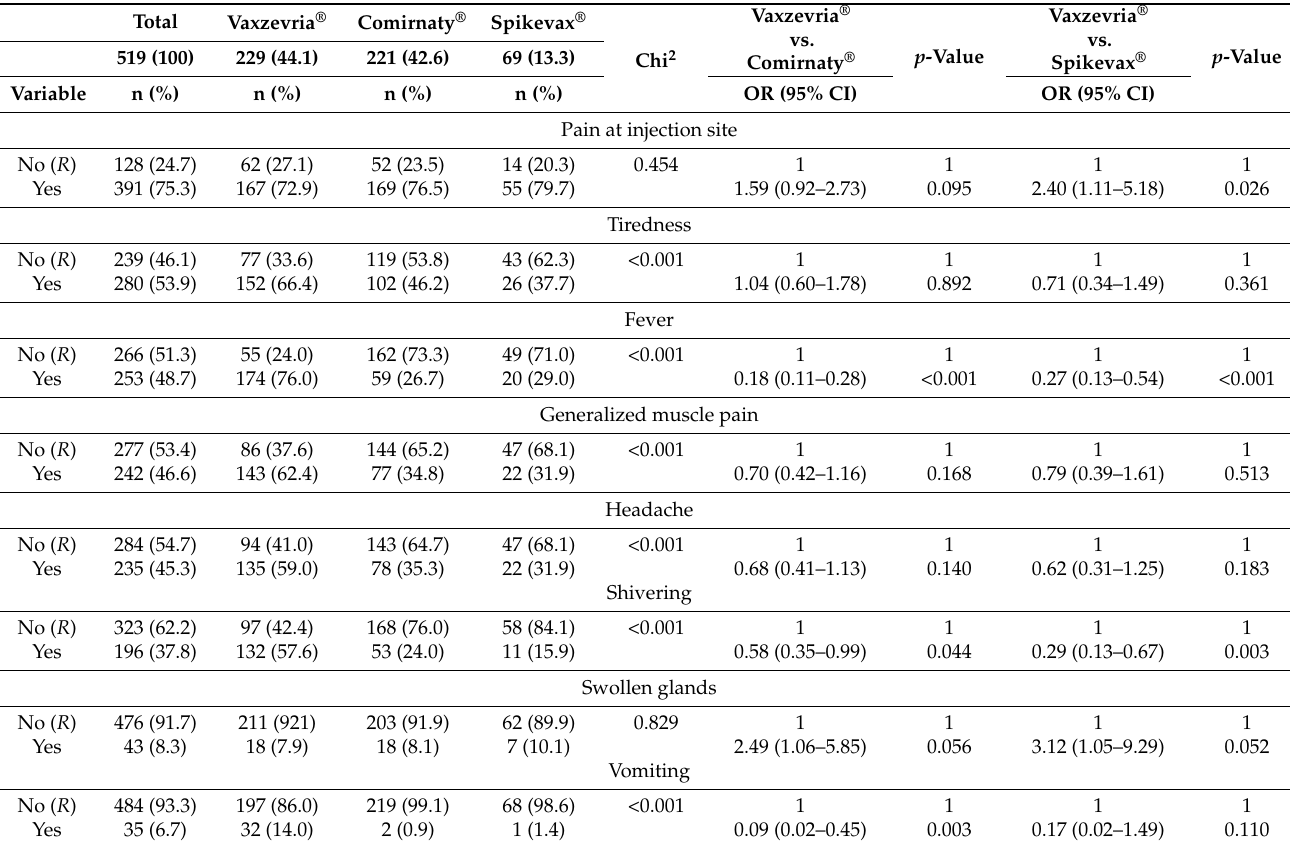
Table 5. Proportion of the occurrence of adverse effects depending on the type of COVID-19 vaccine received and multivariate logistic regression